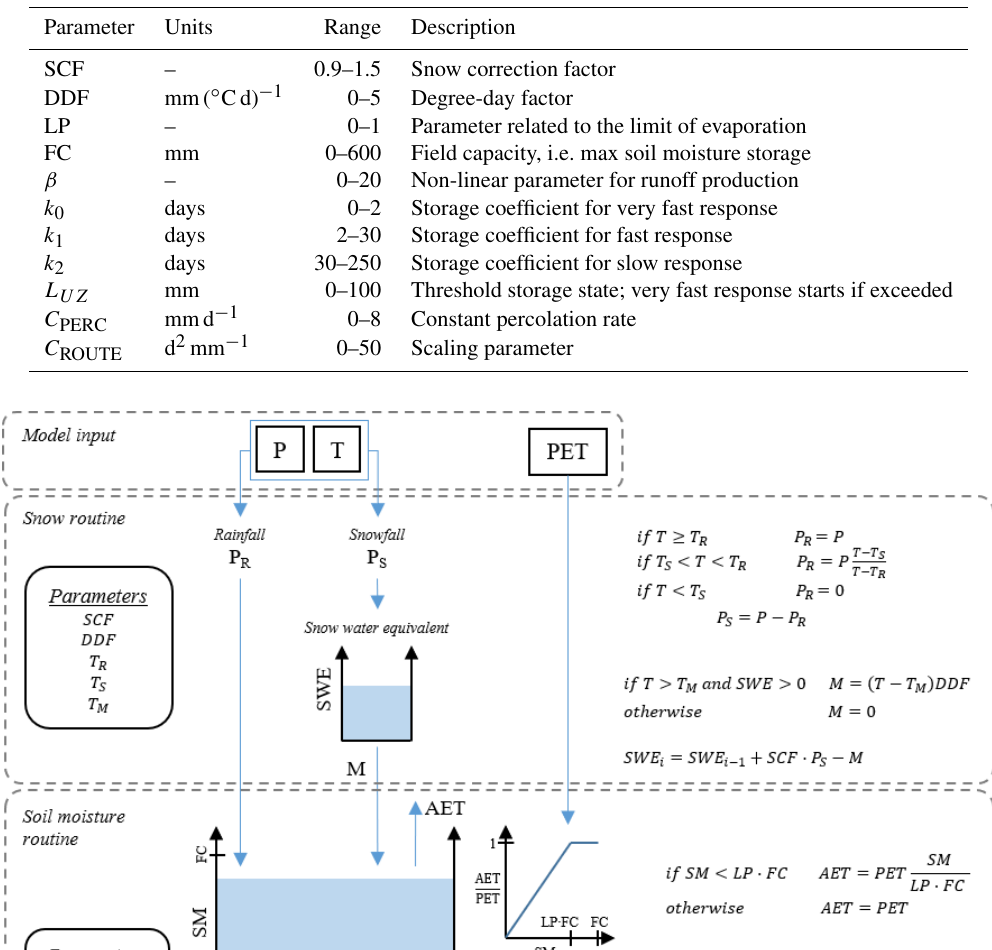
Table 2. TUW model parameters and their ranges.